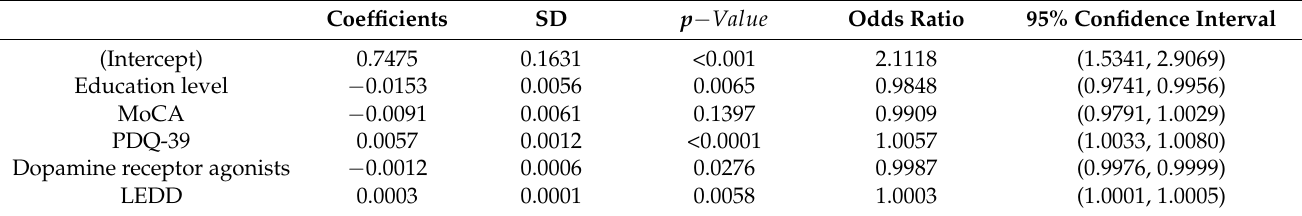
Table 3. Multivariate analysis: Logistic regression of influencing factors of apathy with